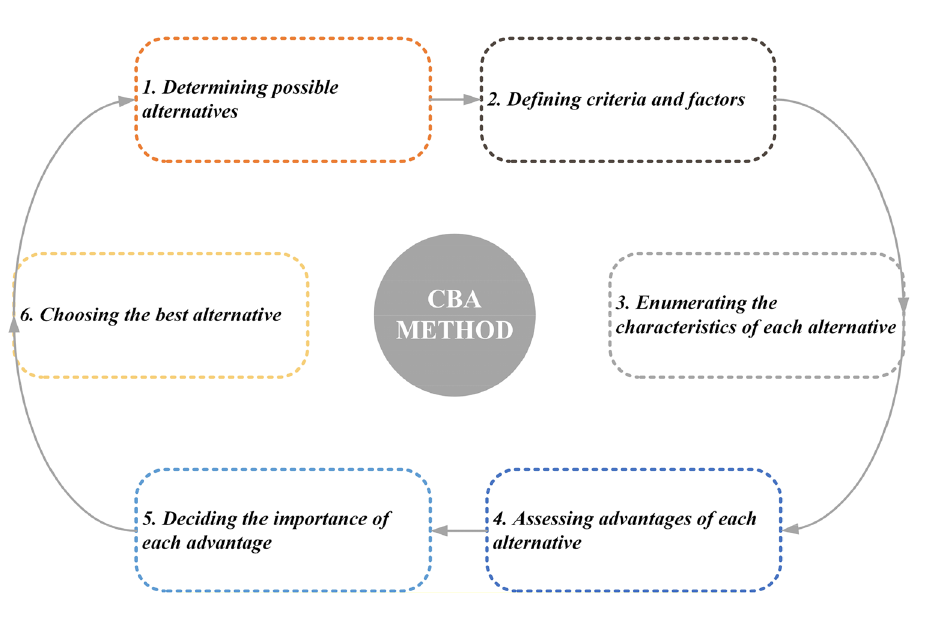
Figure 3. Steps in the CBA method 58 .